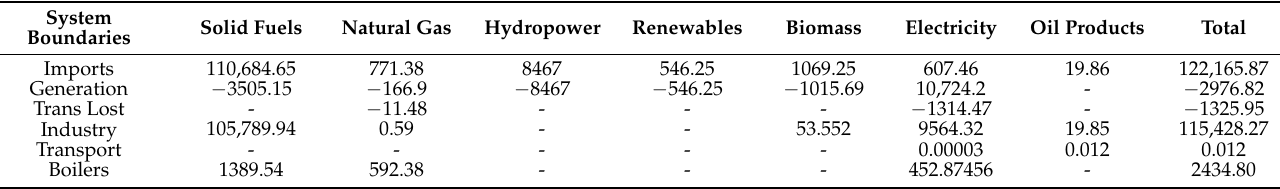
Table 4. Carbon emission values by sector in Panzhihua (Base